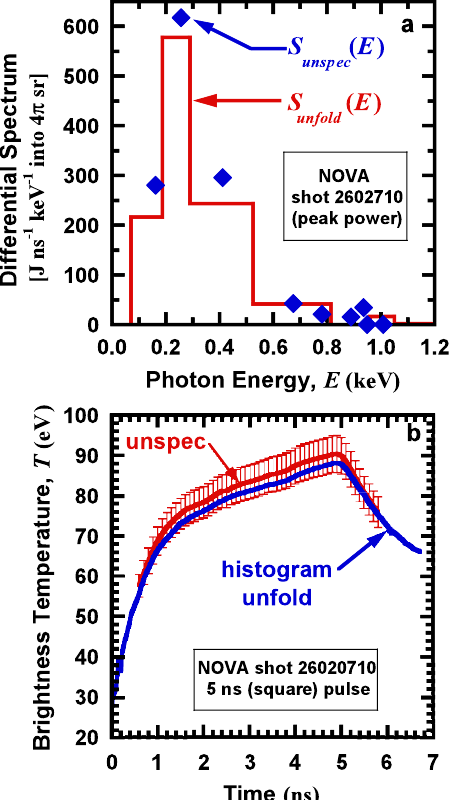
FIG. 12. The results of two unfold methods applied to DANTE data are compared. Data were taken at the NOVA facility (shot 26020710) and were independently unfolded with the UNSPEC code and the histogram unfold technique, given here. No normalizations were used. Part (a) compares the unfolded differential spectra, S at peak emitted x-ray power ( t time-dependent brightness temperature from these two methods. Vertical bars attached to the UNSPEC curve represent (cid:14) 5% -vernier bounds to guide the